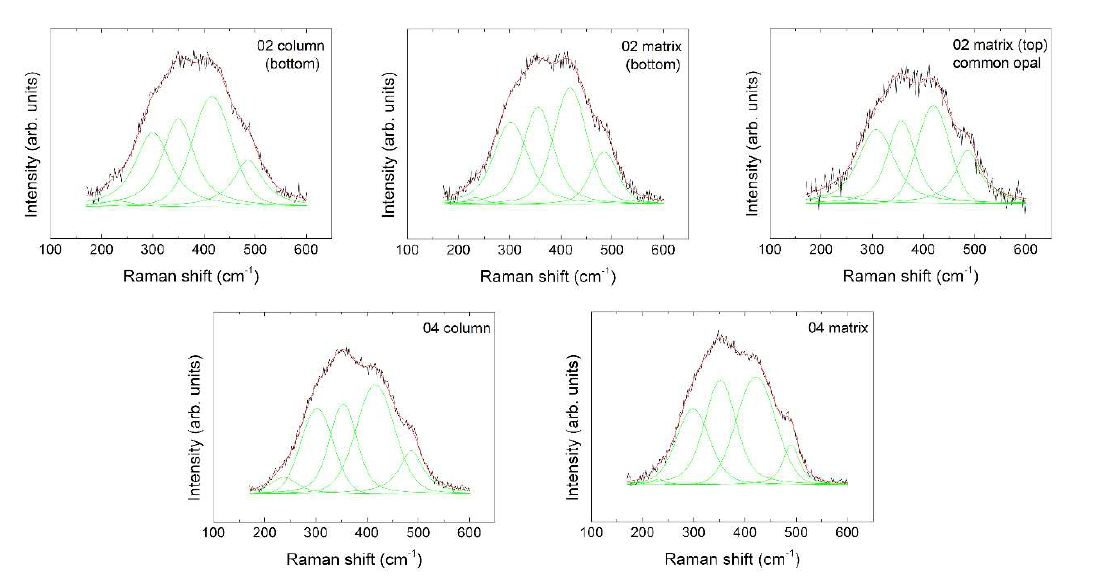
Figure 10. Non-linear curve fitting of Raman spectra of different areas in Opal-02 and 04.